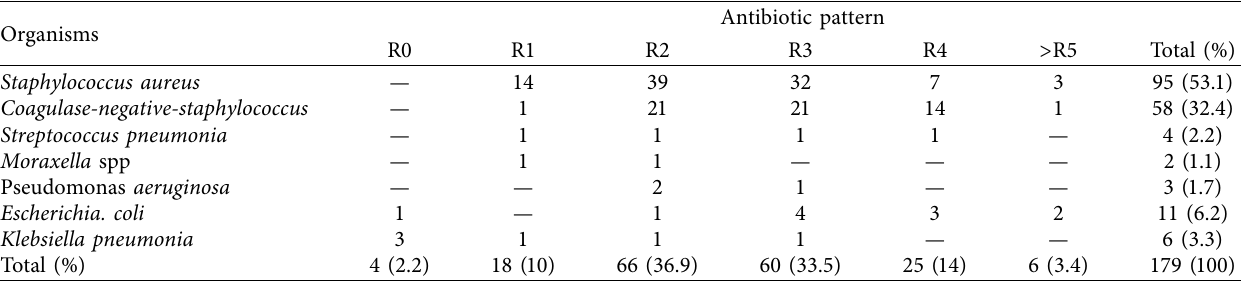
Table 7: Multidrug resistance pattern for patients with external ocular infection attending at Karamara hospital, Jigjiga, eastern Ethiopia, 2020. Organisms Staphylococcus aureus Coagulase-negative-staphylococcus Streptococcus pneumonia Moraxella spp Klebsiella